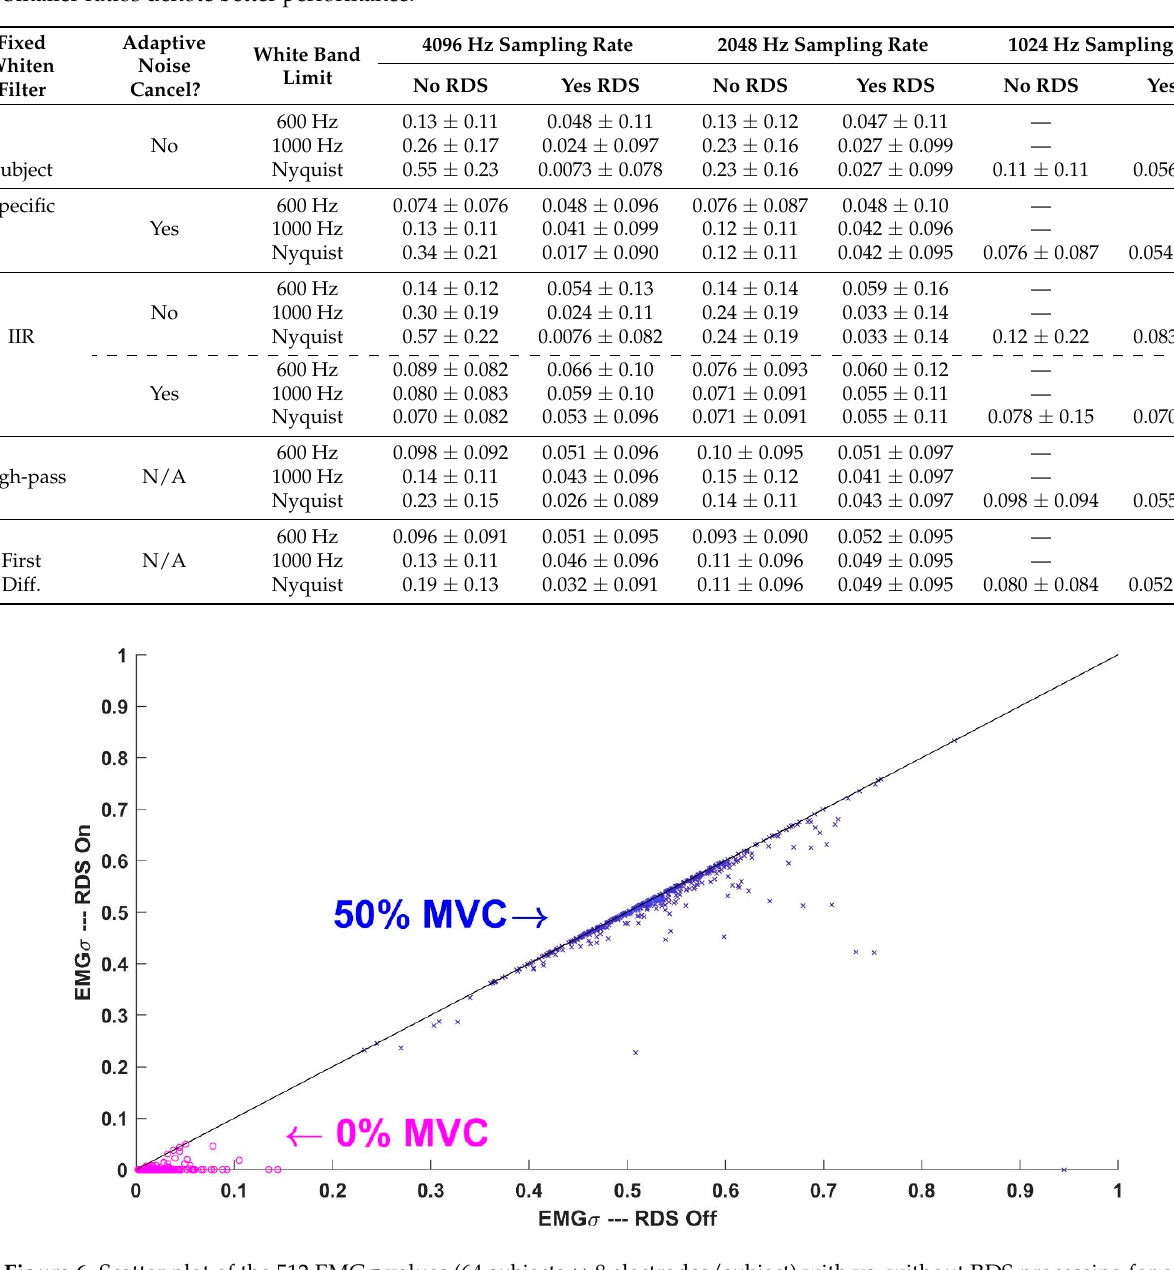
Figure 6. Scatter plot of the 512 EMG σ values (64 subjects × 8 electrodes/subject) with vs. without RDS processing for each of 0% (magenta circles) and 50% (blue x’s) MVC trials. Results correspond to processing with subject-specific whitening adaptive noise canceling, no bandwidth limiting, and a 4096 Hz sampling rate. The clusters of 0% and 50% MVC values do not overlap. The solid black line is the line of agreement.